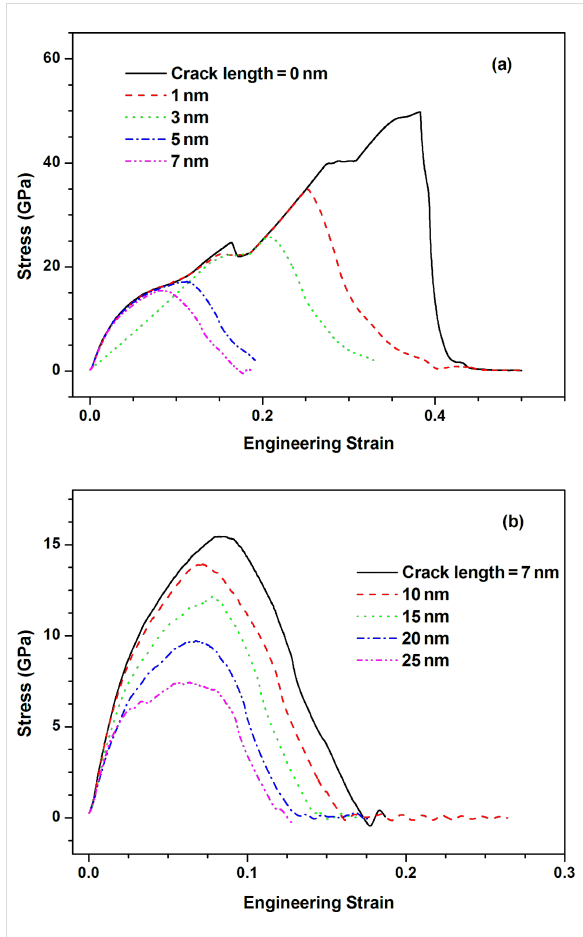
Figure 11: The stress–strain curves along armchair direction of pre- cracked MoS 2 sheet with different crack lengths: (a) 0–7 nm; (b) 7–25 nm.